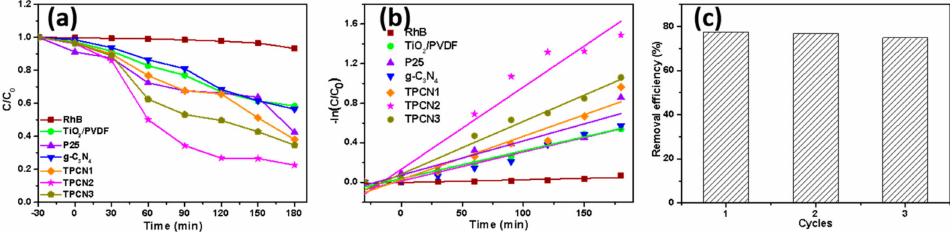
Figure 7. ( a ) Curves of photocatalytic degradation RhB (10 mg / L 50 mL 20 ◦ C) over di ff erent samples: RhB bared, P25 ® , TiO 2 / PVDF and as-prepared TPCN composites. ( b ) Kinetic linear fitting curves for photocatalytic degradation of RhB by di ff erent photocatalysts. ( c ) The durability of TPCN2 for dye removal after several cycles.